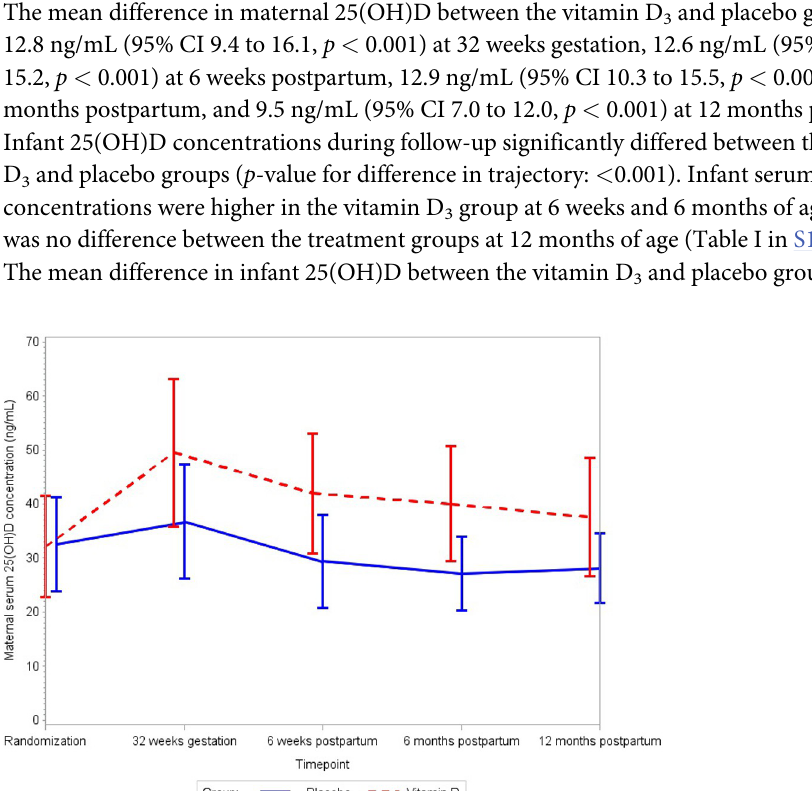
The effects of maternal vitamin D supplementation on maternal and infant serum 25(OH)D 3 concentrations are presented in Figs 3 and 4, respectively. Maternal vitamin D supplementa- 3 tion increased maternal 25(OH)D concentrations during follow-up as compared to placebo ( p -value for difference in trajectory between groups: < 0.001). Maternal 25(OH)D concentra- tions were higher in the vitamin D group at all post-randomization timepoints including 32 3 weeks gestation and 6 weeks, 6 months, and 12 months postpartum (Table H in S1 Appendix). The mean difference in maternal 25(OH)D between the vitamin D and placebo groups was 3